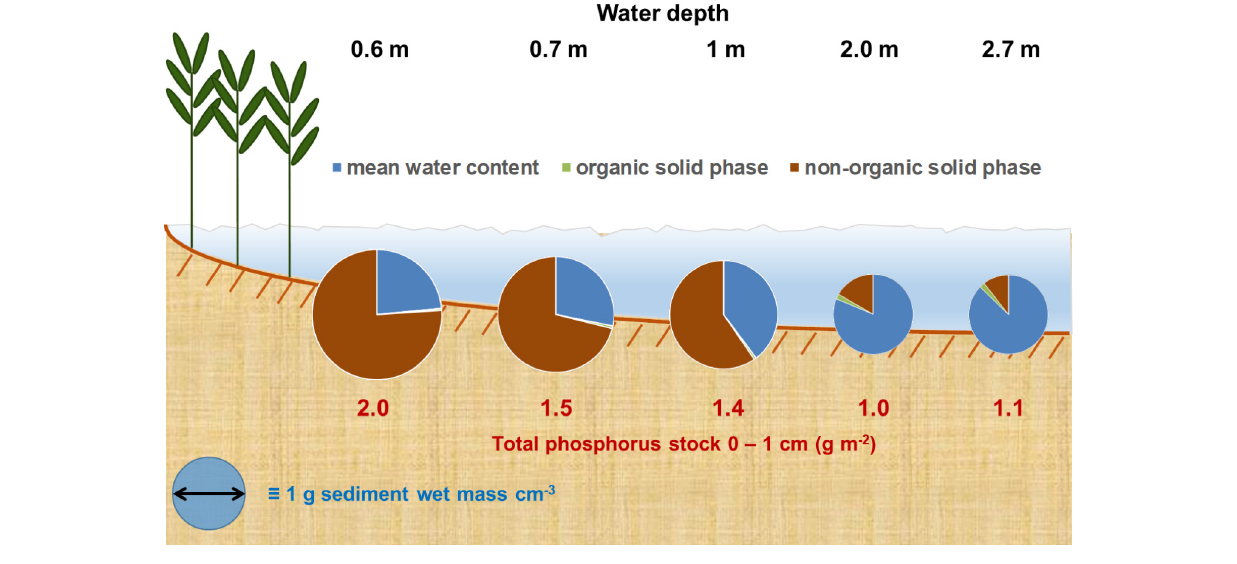
that this small increase represents completely organic